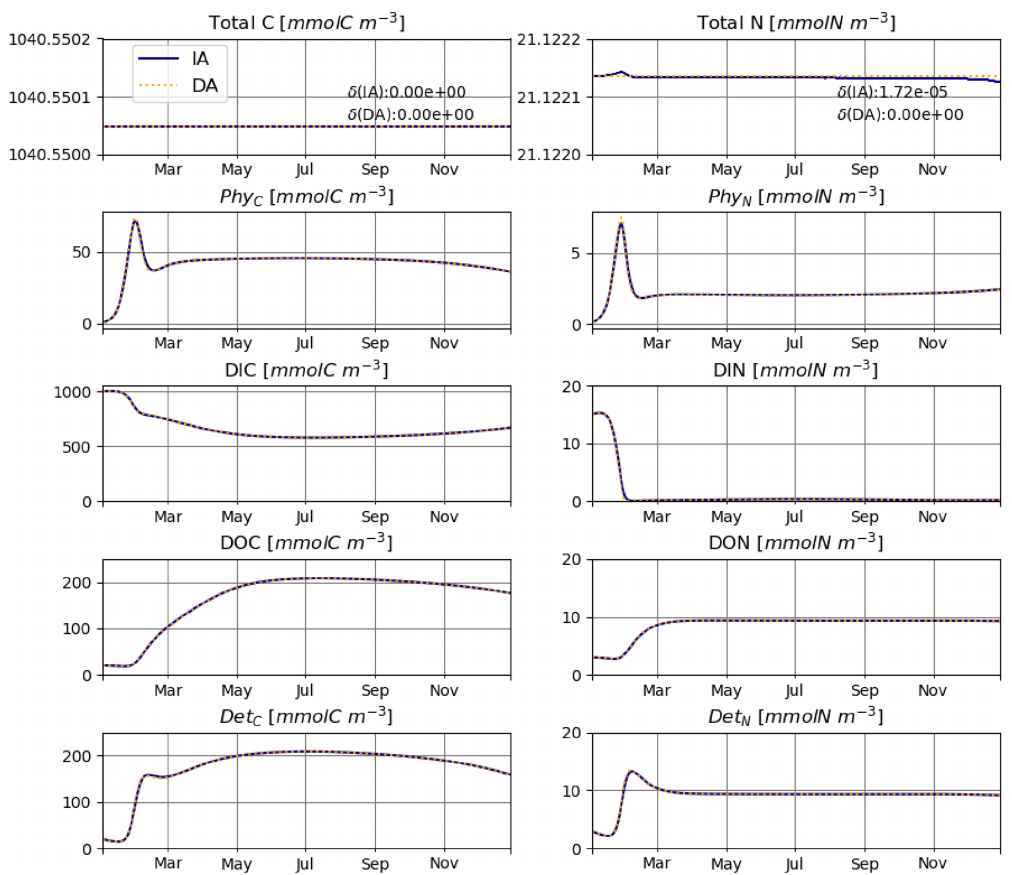
Figure 4. T2: carbon (left) and nitrogen (right) pools for the IA (solid blue line) and DA (dashed orange line) variants with variable day length and